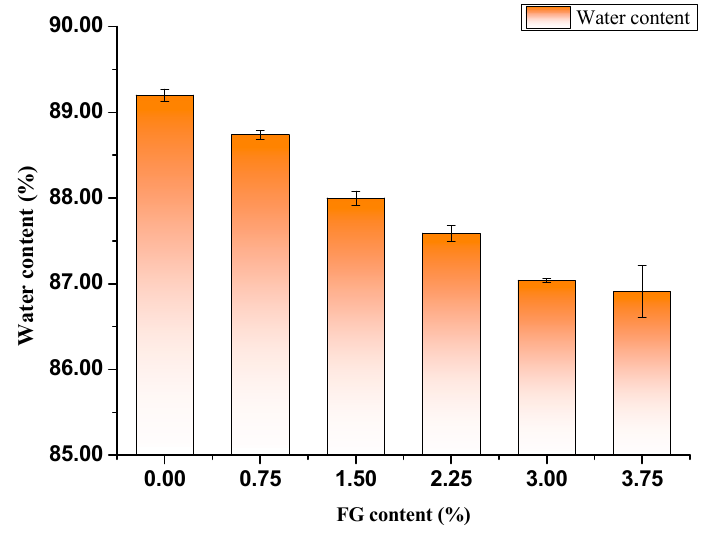
Figure 3. Water content of di ff erent PVA / FG composite hydrogels (10% PVA).